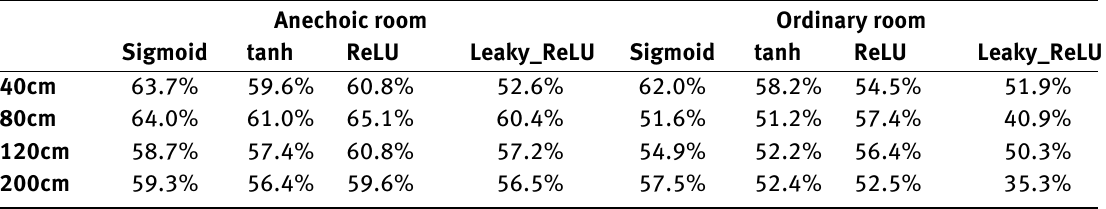
Table 6: Experimental results based on